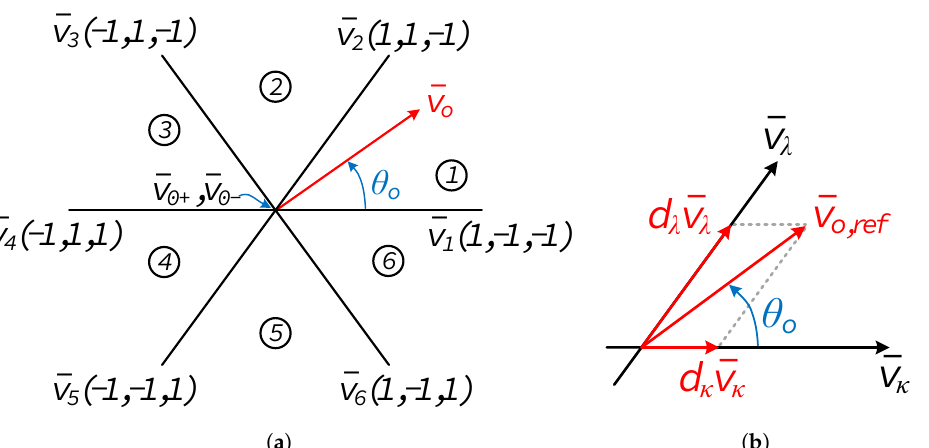
Figure 12. ( a ) Output phase voltage SSVs in αβ frame. ( b ) Generation of the output voltage reference vector v o , ref